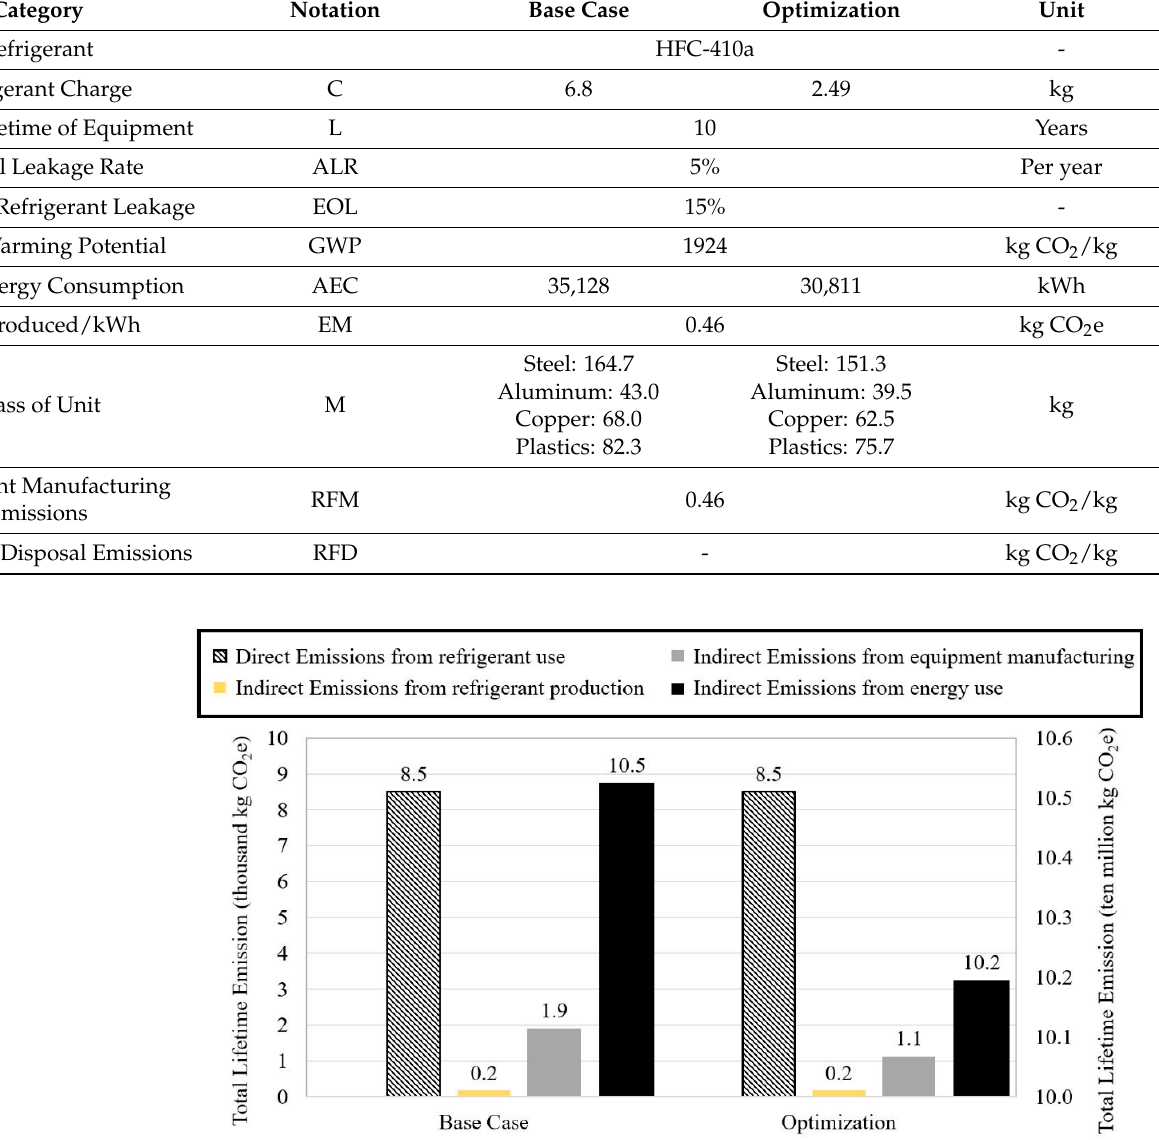
Figure 12. CO 2 emission results.